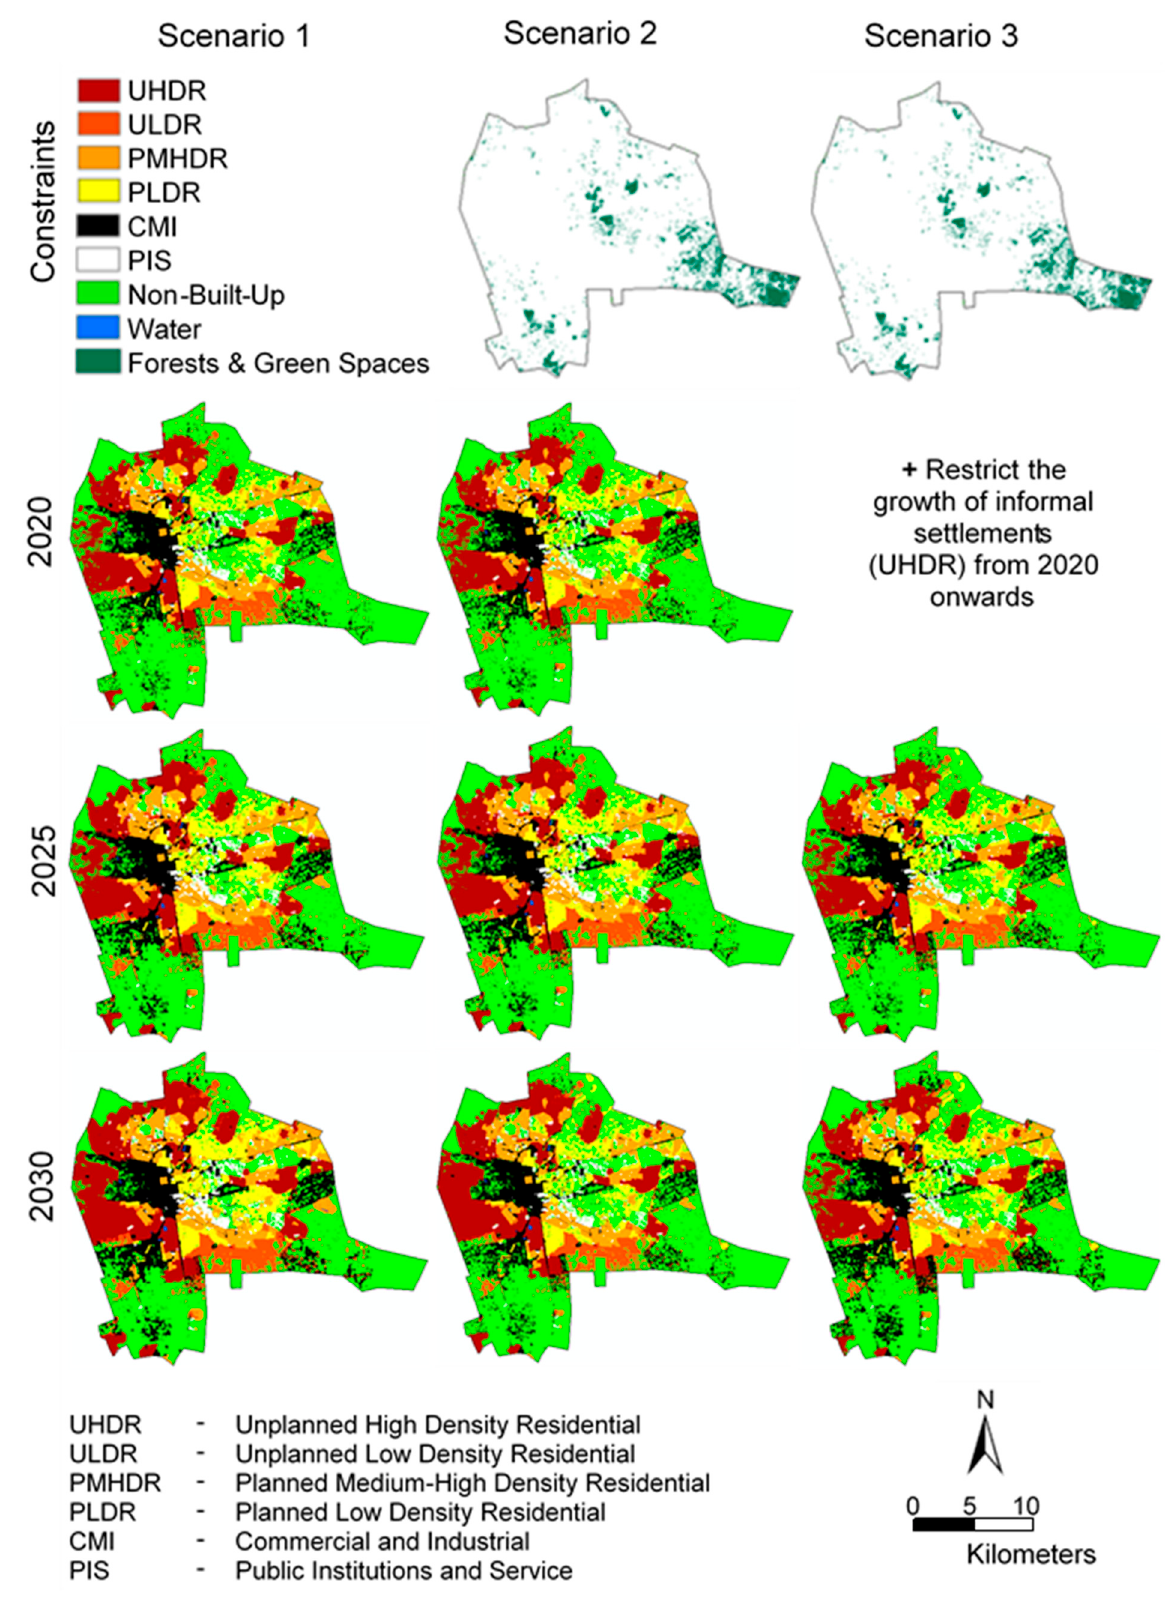
Figure 6. Simulated urban-LU maps for three scenarios in 2020, 2025, and 2030 for Lusaka city, Zambia: Scenario 1, business as usual; Scenario 2, environmental conservation and protection; and Scenario 3, strategic urban planning.